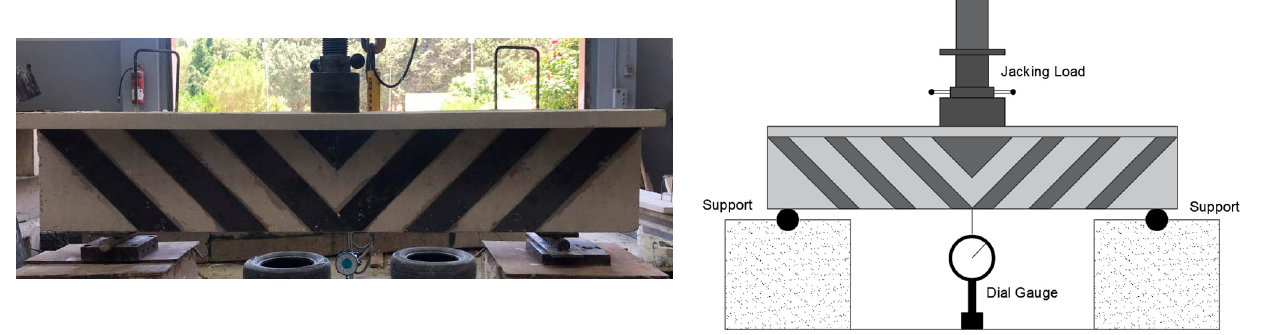
Figure 4. Test Figure 4. Test setup.